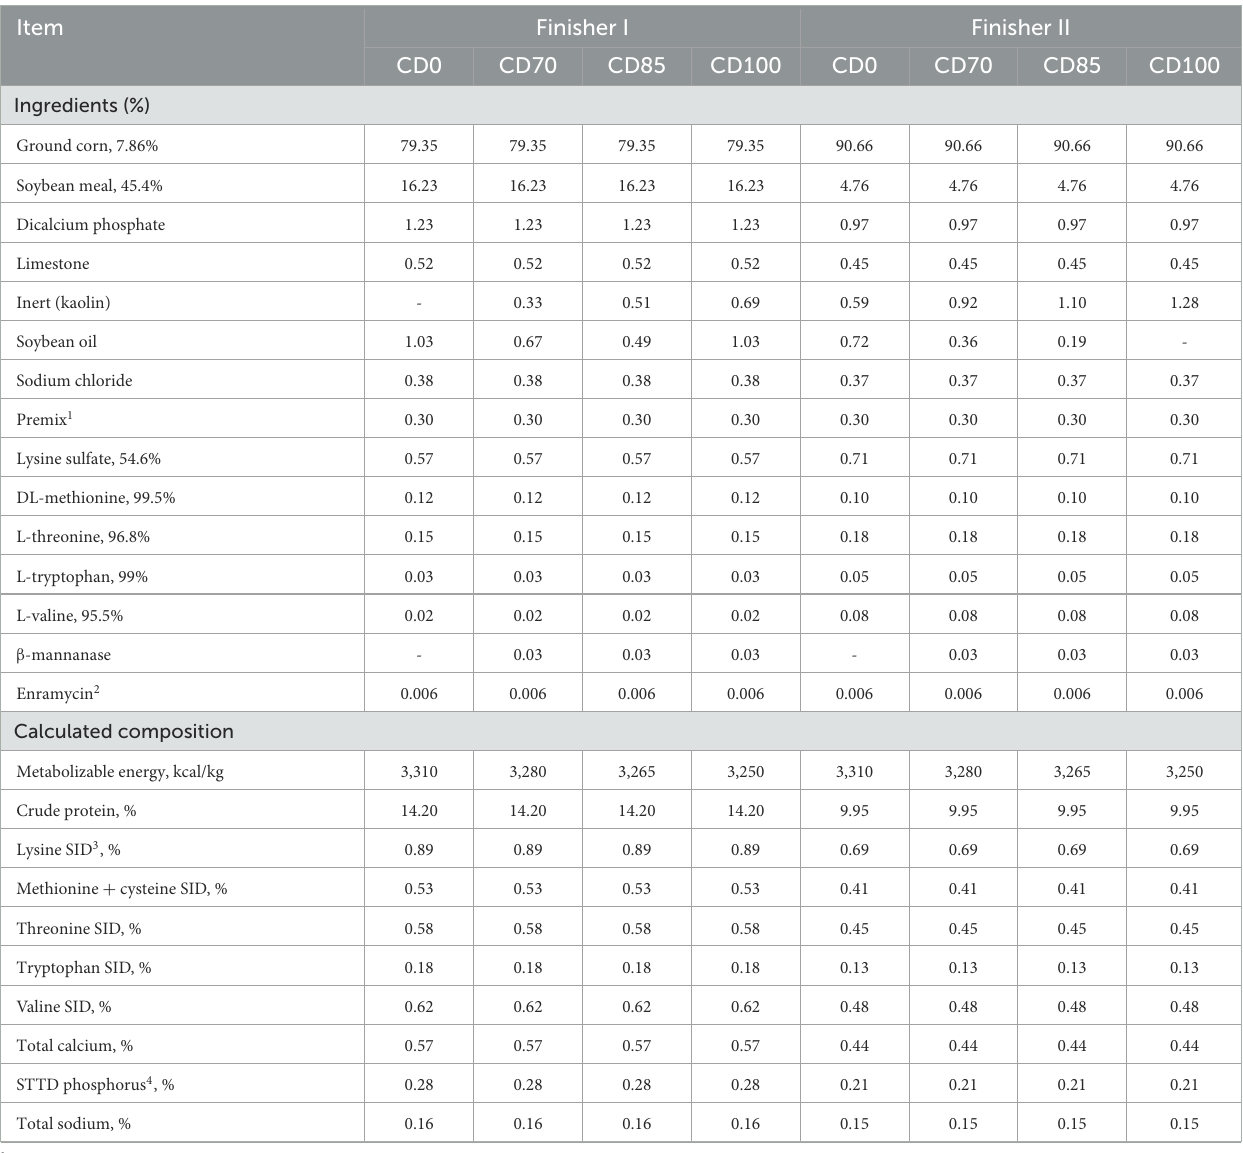
TABLE 1 Composition of diets provided to finisher pigs (as-fed